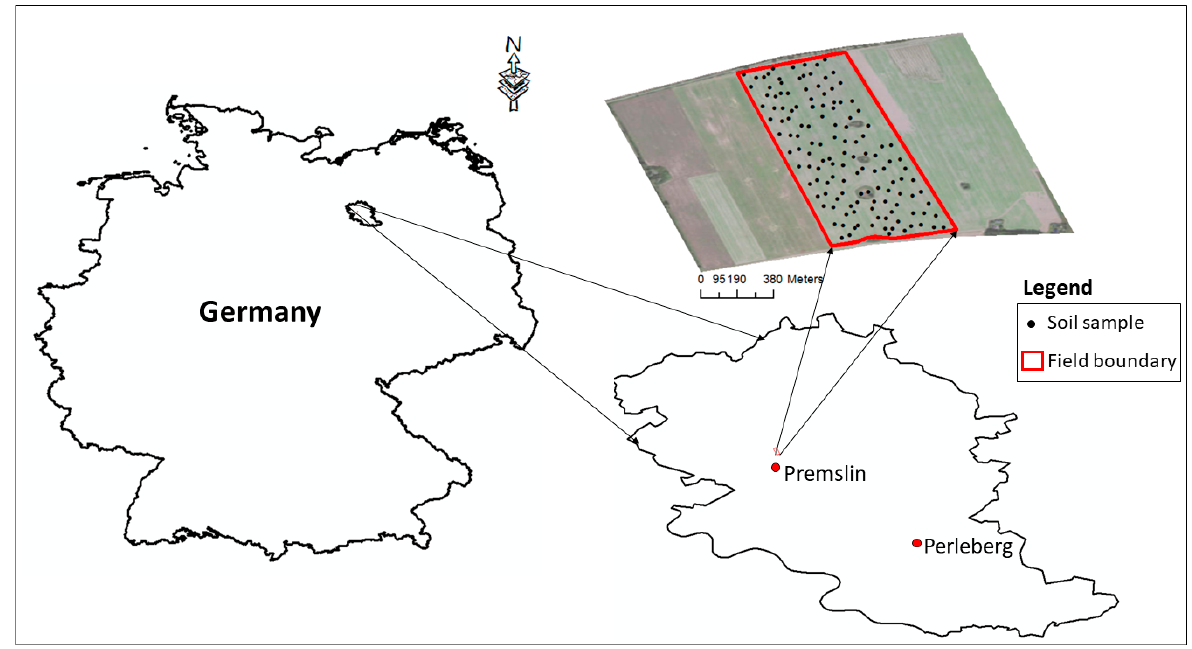
Figure 1. Field location in Premslin near Rostock in Germany, where soil samples and yield data were recorded in 2013 and 2014.